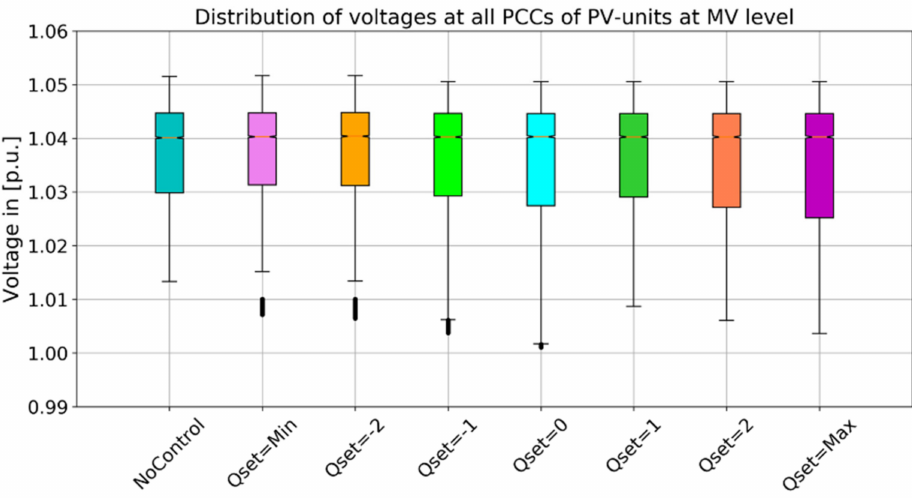
Figure 11. Distribution of voltages at PCCs of all controlled PV units with different requested Q setpoints at 110